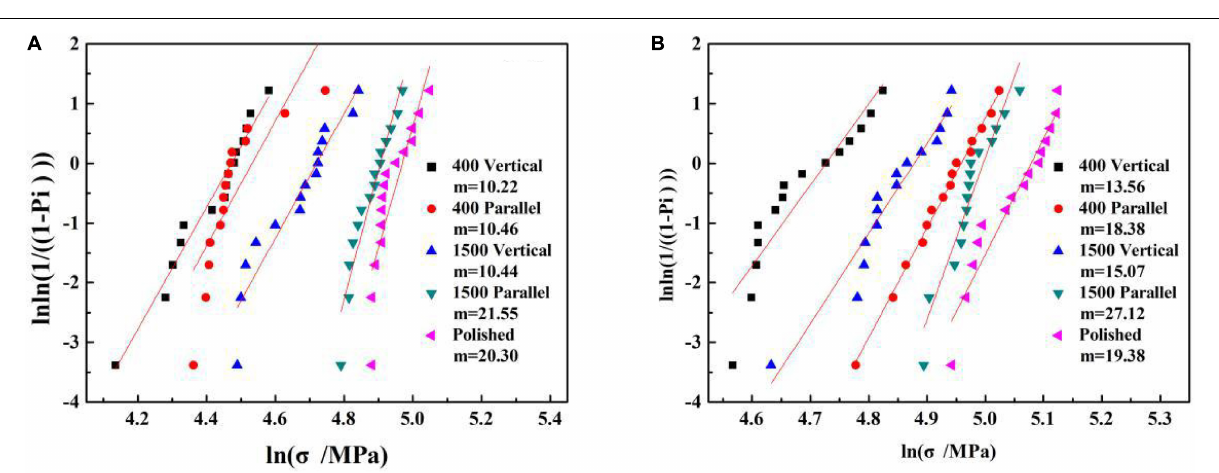
FIGURE 5 | Results of flexural strength of polymer-infiltrated ceramic networks (PICNs) with respect to surface condition. (A) PICN BTC which were sanded and polished with 400# and 1500# abrasive paper. (B) PICN UTC which were sanded and polished with 400# and 1500# abrasive paper.